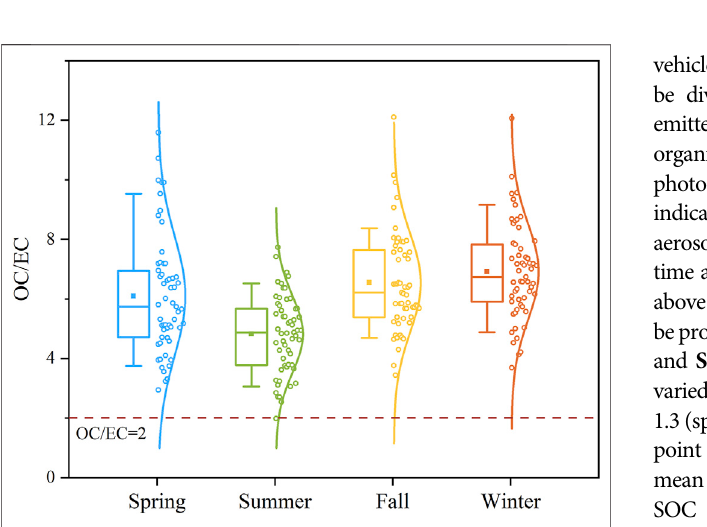
FIGURE 3 | Seasonal variation of OC/EC ratios in Jiuquan